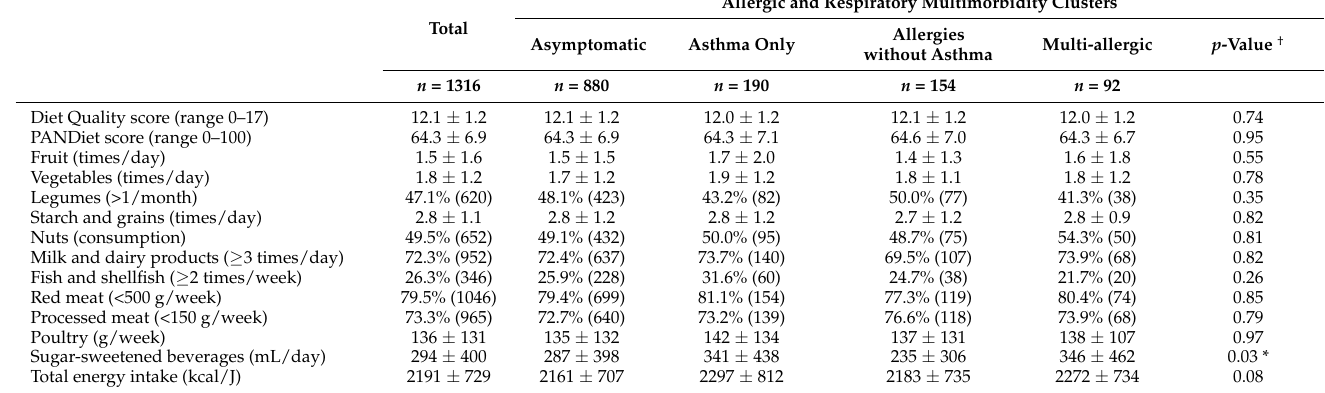
Table 3. Maternal diet characteristics by allergic and respiratory multimorbidity cluster up to 8 years in children ( n = 1316). Allergic and Respiratory Multimorbidity Clusters Total Asymptomatic Asthma Only